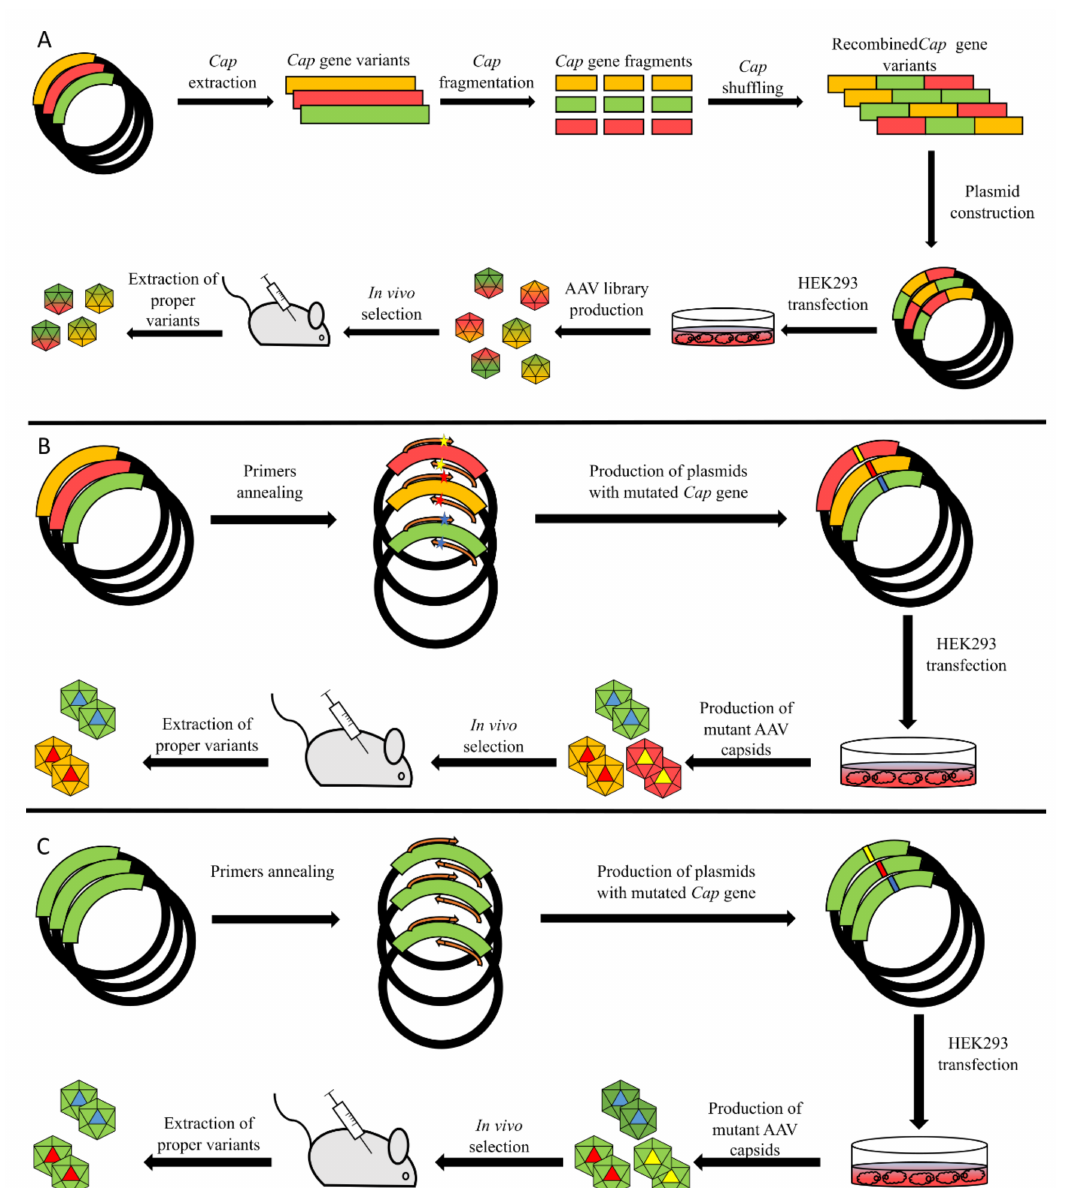
Figure 3. Available methods for AAV library generation. ( A ) Gene shuffling. Red, yellow and green lines represent variants of the Cap gene, which then undergoes fragmentation and shuffling of fragments. Subsequent transfection of AAV-producing cells leads to generation of novel chimeric capsids, which then undergo selection either in a model animal or in tissue culture. After selection, DNA of capsids that transduce target cells is extracted and sequenced to define which shuffled variants of the Cap gene possess the desired properties. ( B ) Site-directed mutagenesis. This method is based on the usage of primers with point mutations (illustrated as colored stars). Afterwards, PCR mutant plasmids are used for production of an AAV library which then undergoes selection. ( C ) Error-prone PCR. The main idea of error-prone PCR is to introduce random mutations into a gene of interest. This can be done with low-fidelity polymerases or with addition of chemical compounds that additionally decrease fidelity of an